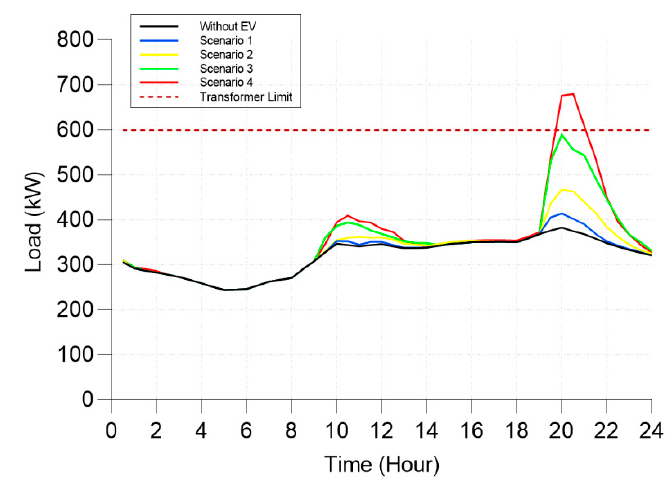
Figure 8. Load profiles for various scenarios with uncoordinated charging.